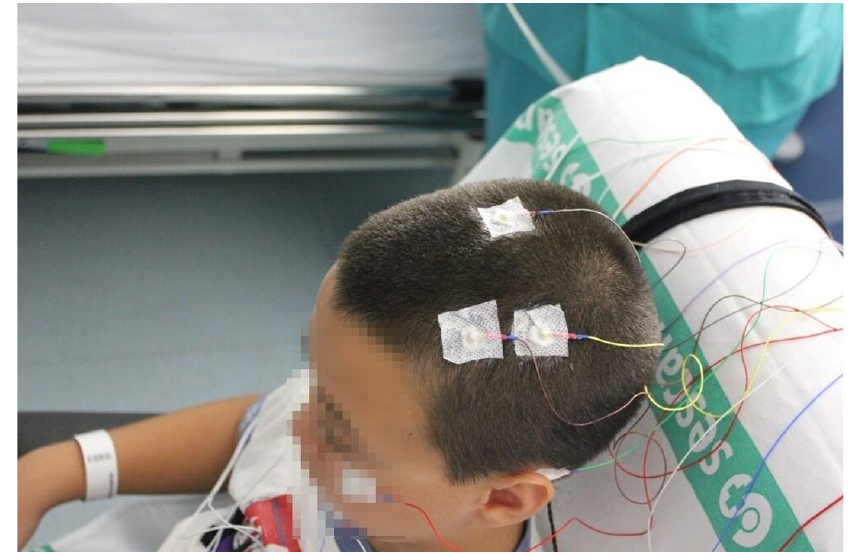
Figure 1. Pediatric polysomnography.